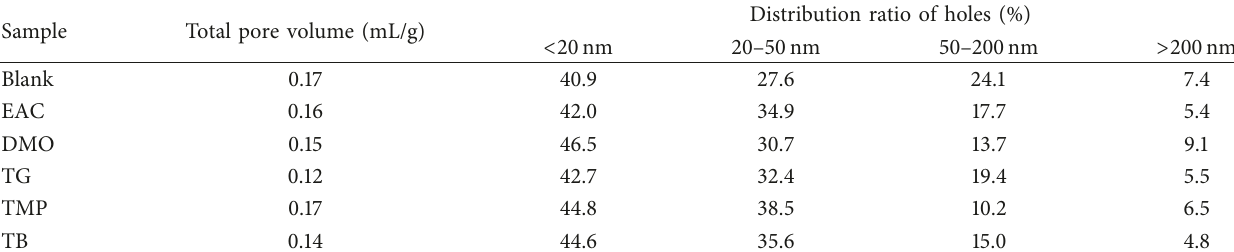
Figure 6: Pore volume distribution at different ages of hardened cement. (a) Differential distribution. (b) Cumulative distribution. Table 5: Pore structural parameters of hardened